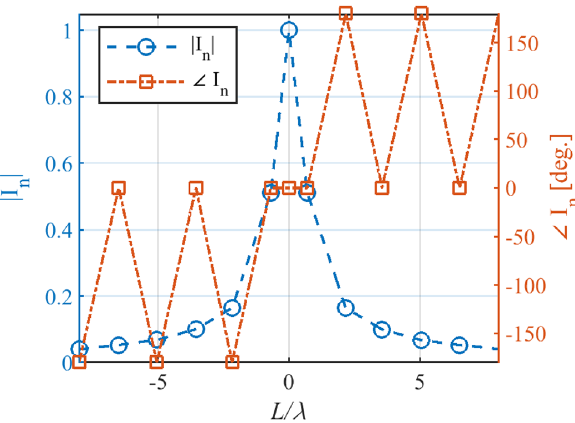
Figure 5. The calculated In versus L/λ for the flat-top pattern.